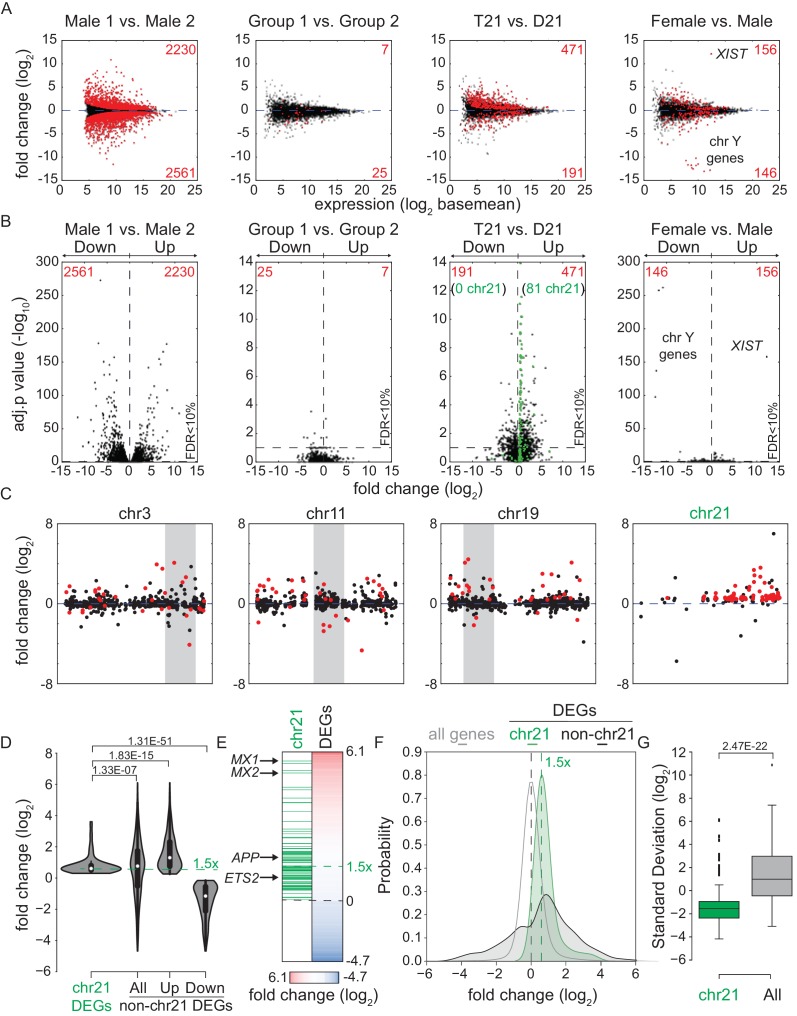
Transcriptome analysis identifies consistent changes in global gene expression between euploid (D21) and trisomy 21 (T21) fibroblasts.(A) MA plots displaying the results of RNA-seq analysis for the indicated comparisons (see Figure 1—figure supplement 1A–C). Differentially expressed genes (DEGs), as defined by DEseq2 (FDR < 10%), are labeled in red. (B) Volcano plots of comparisons in A highlight changes in chr21 gene expression (green) consistent with increased gene dosage effects. (C) Manhattan plots displaying DEGs (red) and all genes (black) for individual chromosomes do not show obvious domains of contiguous upregulation or downregulation. Shaded areas highlight regions of overlapping upregulation and downregulation (see Figure 1—figure supplements 2A and 3). (D) Violin plots of chr21 and non-chr21 DEGs displaying the distribution of fold changes of DEGs in each category. p-values were calculated with the Kolmogorov-Smirnov test. (E) Heatmap of all significant DEGs showing clustering of chr21 DEGs (green) around 1.5 fold upregulation in T21 cells. (F) Kernel density estimate plot highlighting the probabilities of chr21 DEGs (green, green dashed line indicates median), non-chr21 DEGs (black, black dashed line indicates median), and all genes (gray), of having a given fold change. (G) Box and whisker plot of standard deviations of fold changes in DEGs for six pairwise comparisons of age- and gender-matched T21 versus D21 fibroblasts showing greater variation in fold change for non-chr21 DEGs. p-values were calculated with the Kolmogorov-Smirnov test.